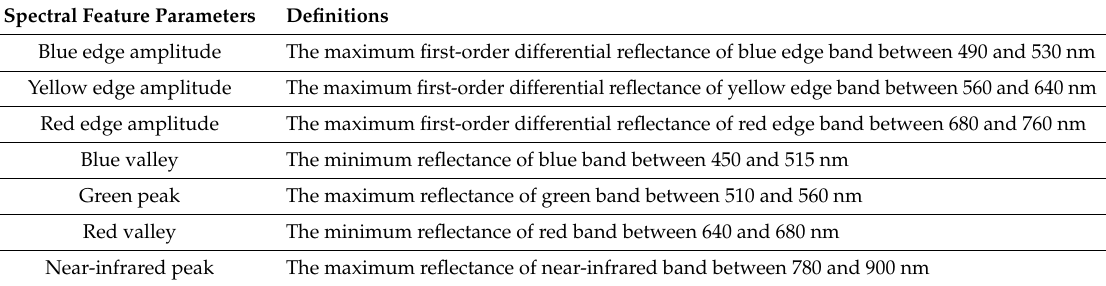
Table 2. Definitions of spectral feature